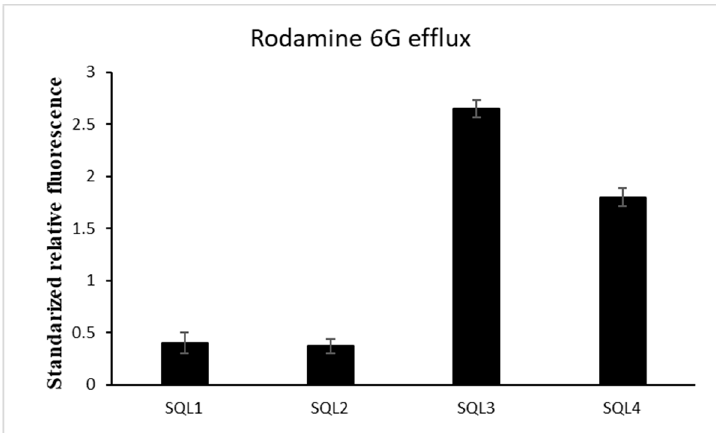
Figure 4. Styrylquinolines (½MIC) influence on energy-dependent rhodamine 6G efflux 30 min after efflux was induced by adding glucose. (±SD, n = 3).